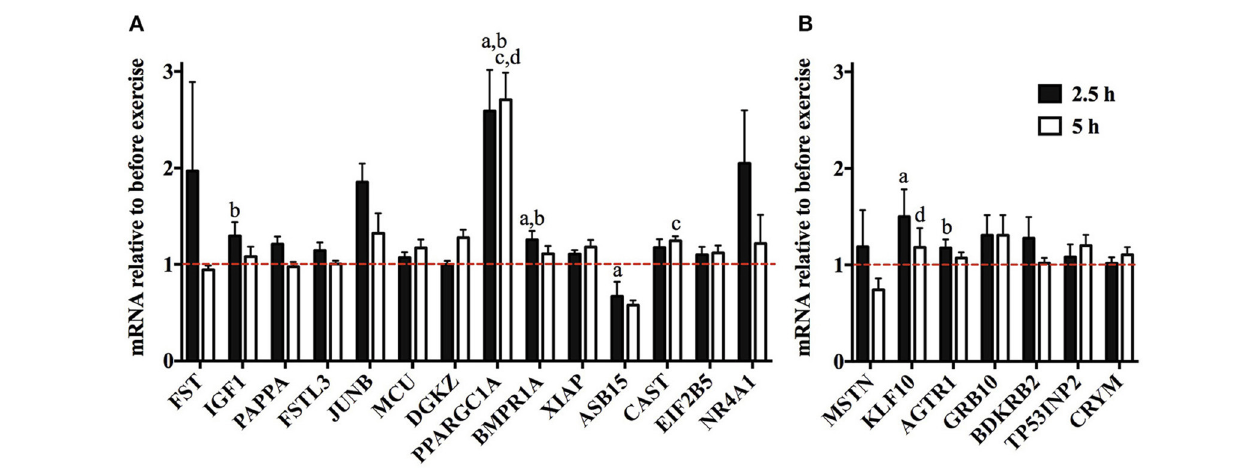
FIGURE 3 | Expression of muscle mass regulating genes after resistance exercise. Transcriptome data GSE23244 from Vissing and Schjerling (2014) was accessed to discover which muscle mass regulating genes are induced or repressed 2.5h or 5h relative to resting value after a bout of resistance exercise. (A) Expression of genes whose overexpression or activation increases muscle mass in mice. (B) Expression of genes whose knock out increases muscle mass. Genes whose mean expression increased or decreased by more than 10% are shown in this figure. a Different at 2.5h compared to pre-training, b Different compared to control group at 2.5h, c Different at 5h compared to pre-training, d Different compared to control group at 5h ( n = 6). Note that the data for pan PPARGC1A are shown. However, muscle hypertrophy is only stimulated by the PGC-1 α 4 protein isoform ( Ruas et al., 2012).